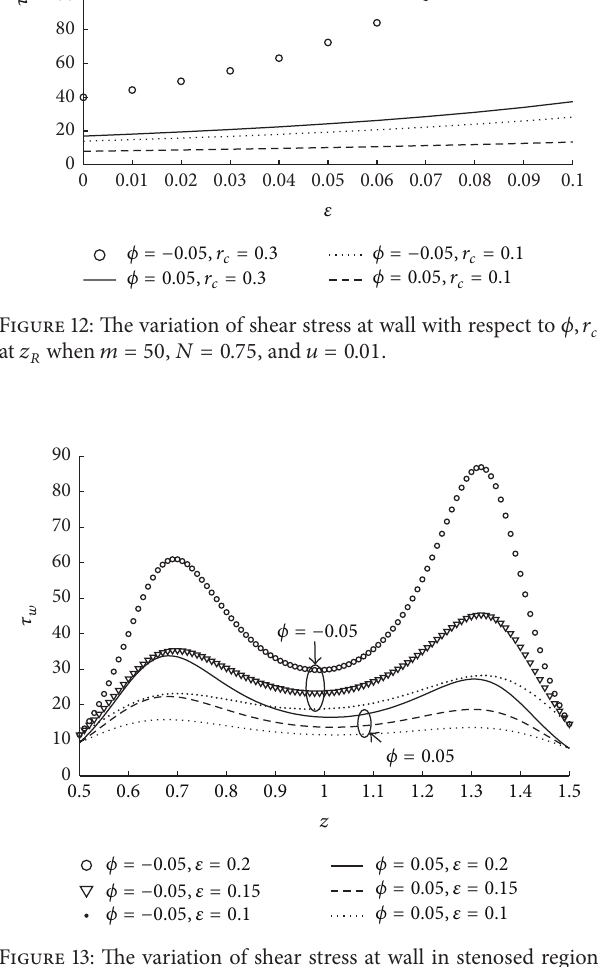
Figure 11: The variation of shear stress at wall with respect to 𝜙,𝑁 at 𝑧 𝐿 when 𝑚 = 10 , 𝑟 𝑐 = 0.1 , and 𝑢 = 0.01 .